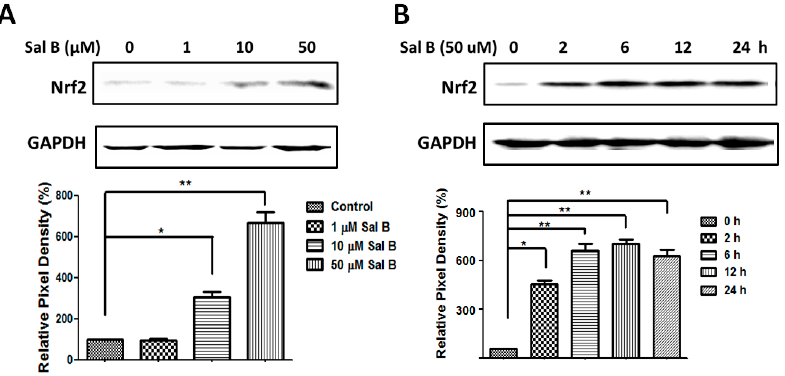
Figure 6. Sal B activates NF-E2-related factor 2 (Nrf2) pathway in RPE cells. ( A ) Dose-dependent effects of Sal B on Nrf2 expressions. RPE cells were treated with (1–50 μ M) Sal B for 24 h. Control cells were treated identically but without addition of Sal B. Bottom panel: The relative pixel density of Nrf2 over GAPDH; ( B ) dose-dependent effects of Sal B on Nrf2 expression. RPE cells were treated with or without Sal B for 2, 6, 12, and 24 h. Bottom panel: The relative pixel density of Nrf2 over GAPDH. Data are mean ± SEM of three independent experiments, * p < 0.05, ** p < 0.01 compared with the control group.